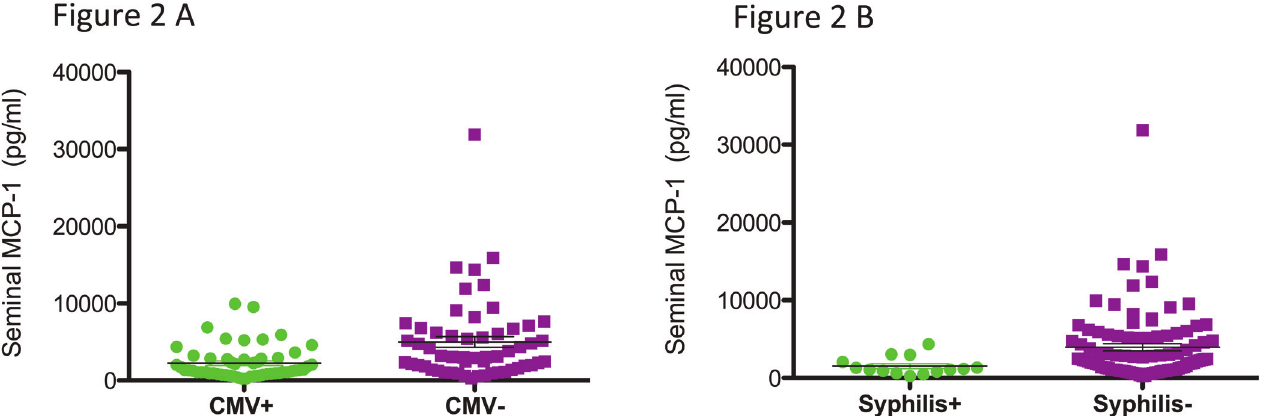
Fig 2. Genital MCP-1 levels, CMV shedding and syphilis acquisition. CMV shedding (panel A) and syphilis acquisition (panel B) were both associated with LOWER seminal MCP-1 levels (Mann Whitney